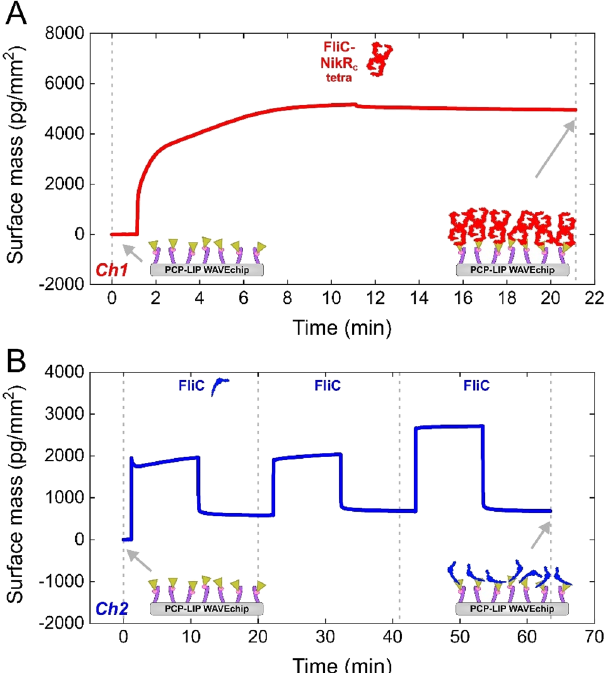
Figure 4. ( A , B ) FliC-NikR C and FliC immobilization series performed on PCH chip using channel Ch1 and Ch2 , respectively. The series included the injection of FliC-NikR C and FliC solution reaching 4950 pg/mm 2 and 680 pg/mm 2 adsorbed masses, respectively. All cycles involve a baseline (RB injection), a flagellin injection as well as a washing (RB injection) section (cycle sections are not indicated on the graph but can be followed according to the upgoing/dropping curves). The schemes on the bottom of the graphs illustrate the quasi-planar PCP coating with lipophilic functions and immobilized flagellin molecules.